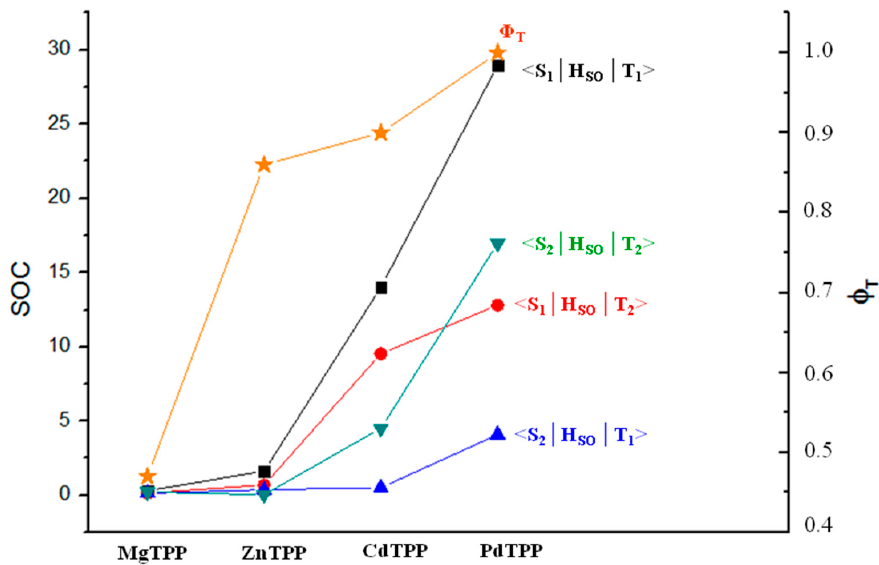
Figure 2. Computed SOCs (cm -1 ) for S n –T m (with n and m = 1, 2) radiationless transitions and measured [35] triplet quantum yields ϕ T for the investigated systems.